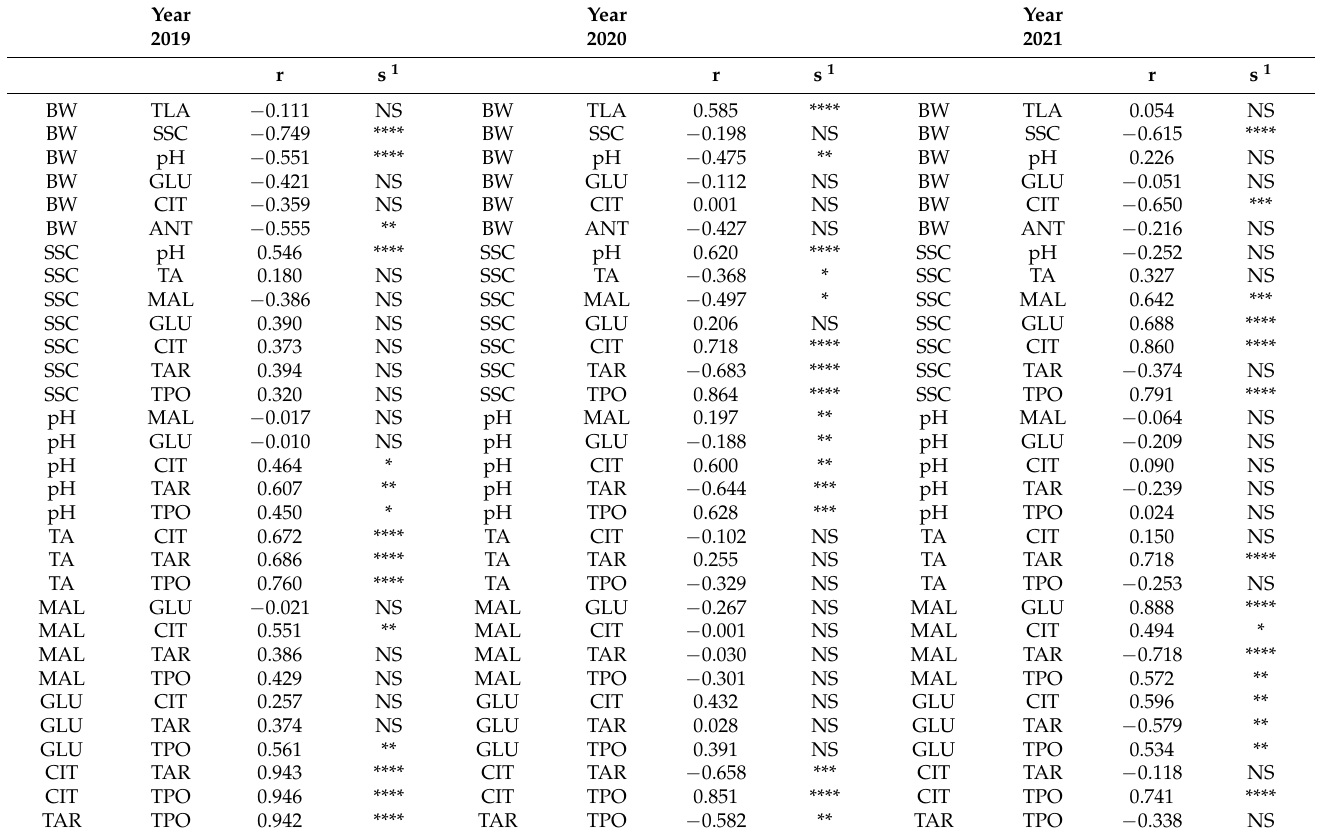
Table 6. Correlations among the main analyzed parameters during the three-year